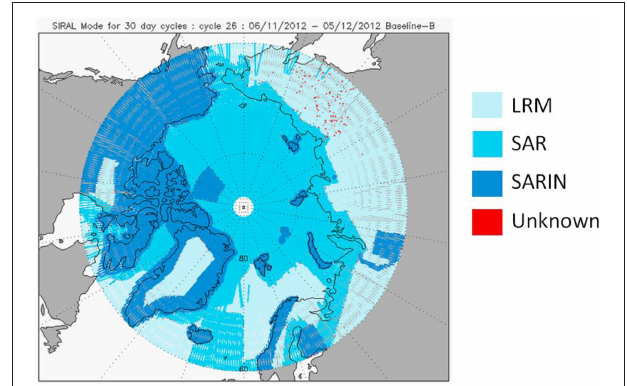
FIGURE 1 | An example of the mode mask of Cryosat-2 for the Arctic Ocean for November 2012. The mask is dynamically changing with time. Faint blue regions means that data in LRM mode. Light blue is data in SAR and dark blue is data in SAR-in. Picture is from Cryosat-2 mission quality monitoring center (http://cryosat.mssl.ucl.ac.uk/qa/mode.php).